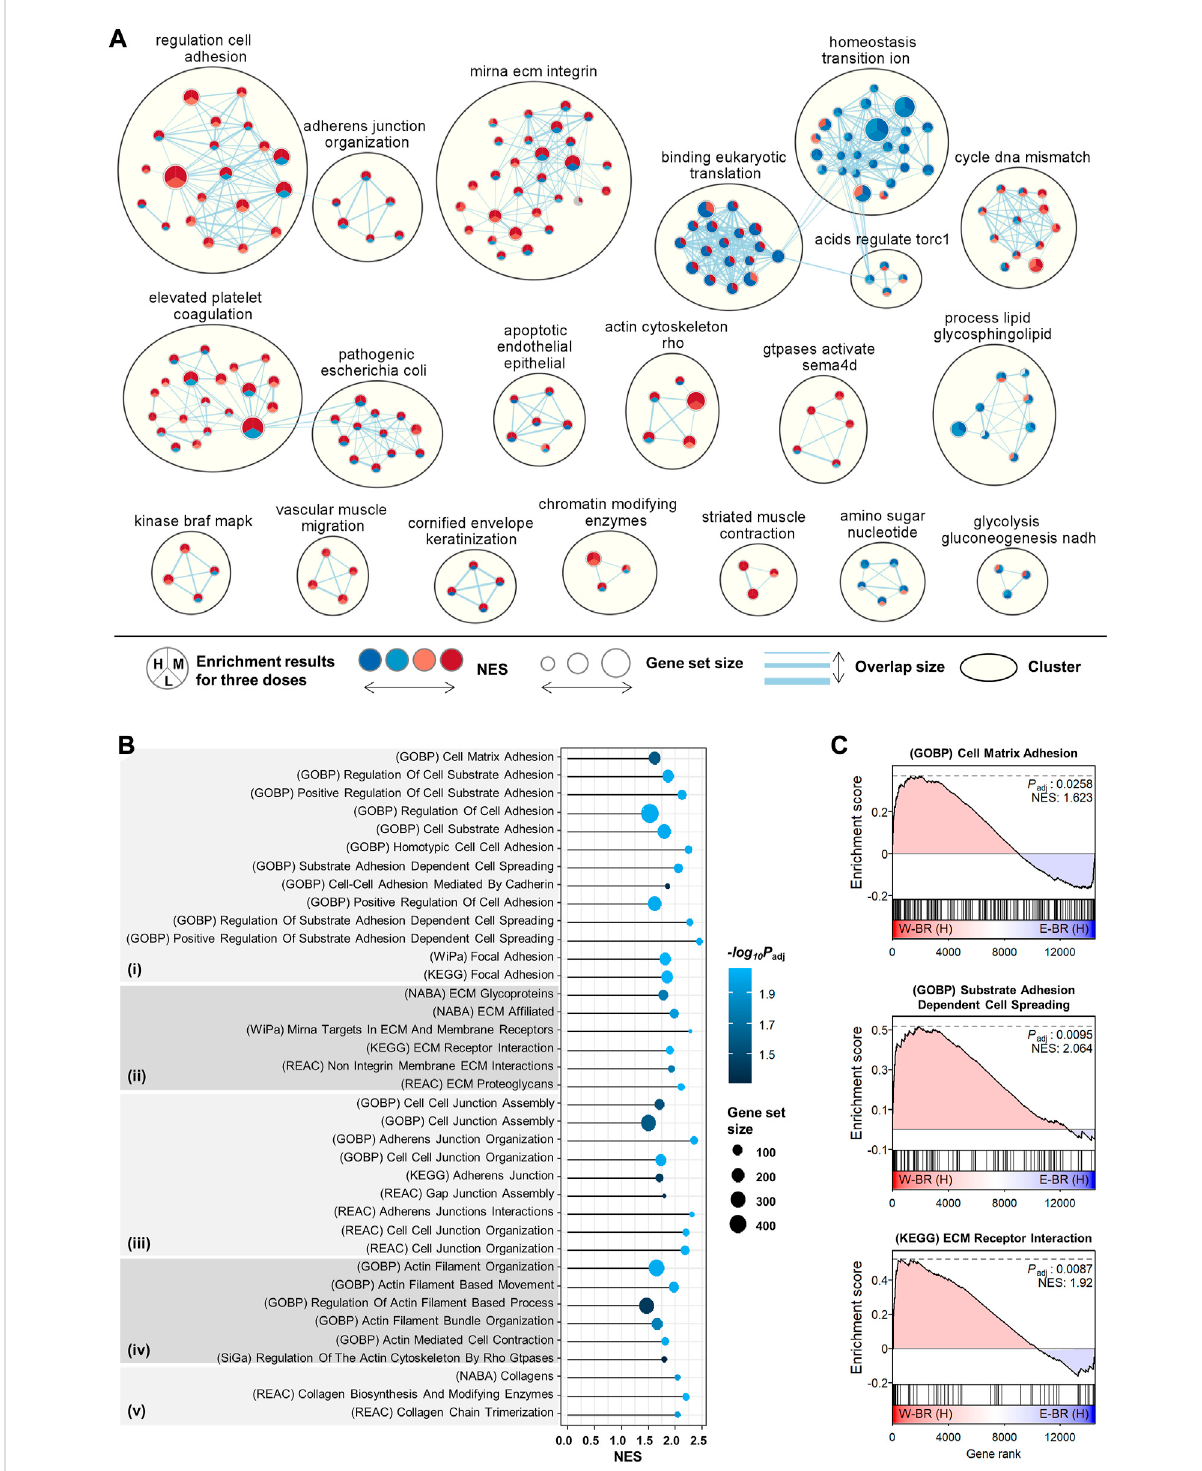
FIGURE 2 Enriched pathways in bupleuri radix water extract (W-BR) compared to bupleuri radix ethanol extract (E-BR). (A) Network analysis of enriched pathways using the EnrichmentMap application in Cytoscape. The curated and ontology gene sets were included from the misigDB. The clusters with more than three pathways were represented. (B) gene set enrichment analysis (GSEA) results for the selected pathways involved in adhesion (i) , extracellular matrix (ii) , junction (iii) , actin (iv) , and collagen (v) . (C) The selected GSEA plots for cell-matrix adhesion, cell-substrate adhesion, and cell spreading. L, M, or H denotes the conditions of low, medium, or high dose, respectively. GOBP, Gene Ontology Biological Processes; WiPa, Wikipathway; REAC, Reactome; KEGG, Kyoto Encyclopedia of Genes and Genomes; NABA, Naba (A) E-BR: bupleuri radix ethanol extract ; W-BR: bupleuri radix water